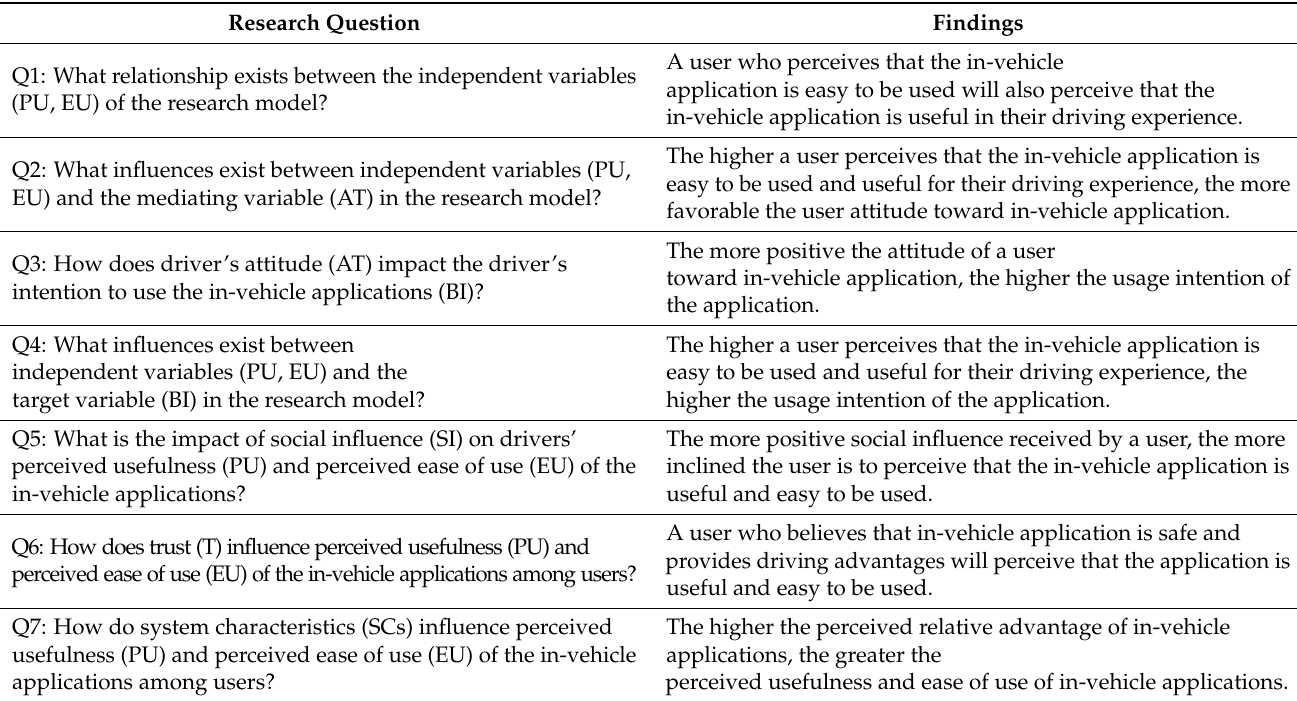
Table 18. Findings based on research